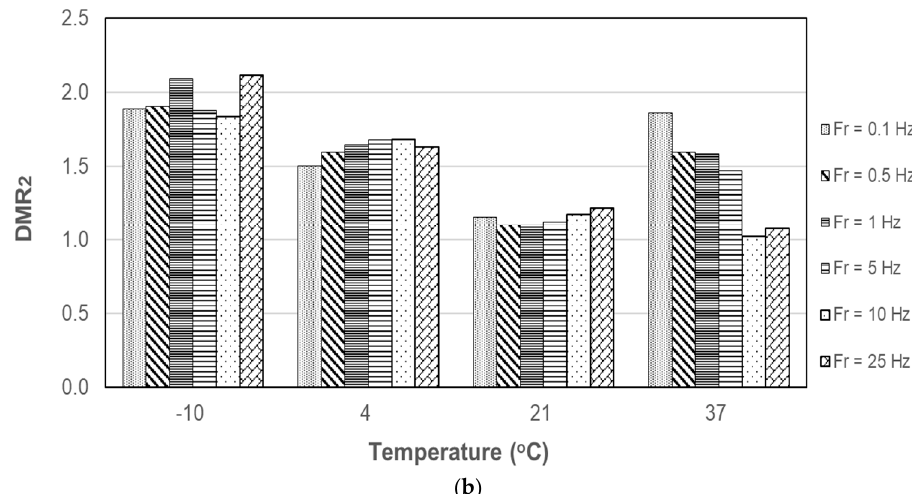
Figure 8. DMR of PA20: ( a ) after first cycle conditioning; ( b ) after second cycle conditioning.